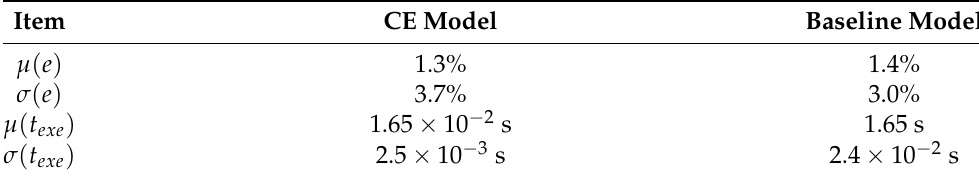
Table 2. Error ( e ) and computation time ( t exe ) of the diesel HGV’s CE and baseline models.